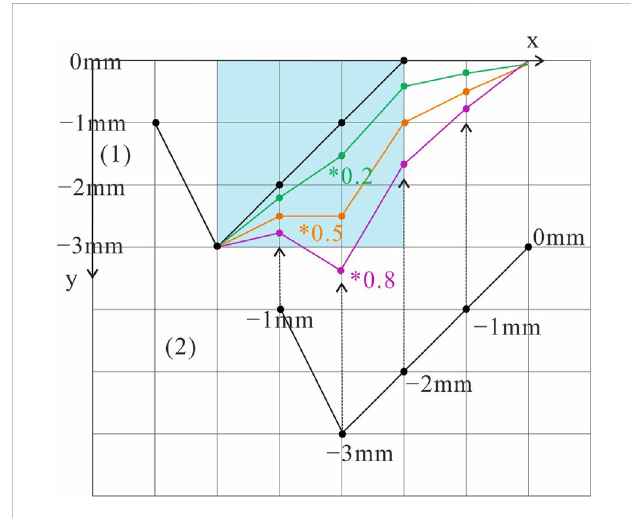
FIGURE 14 Simpli fi ed diagram of the cause of the subsidence curve of the upper